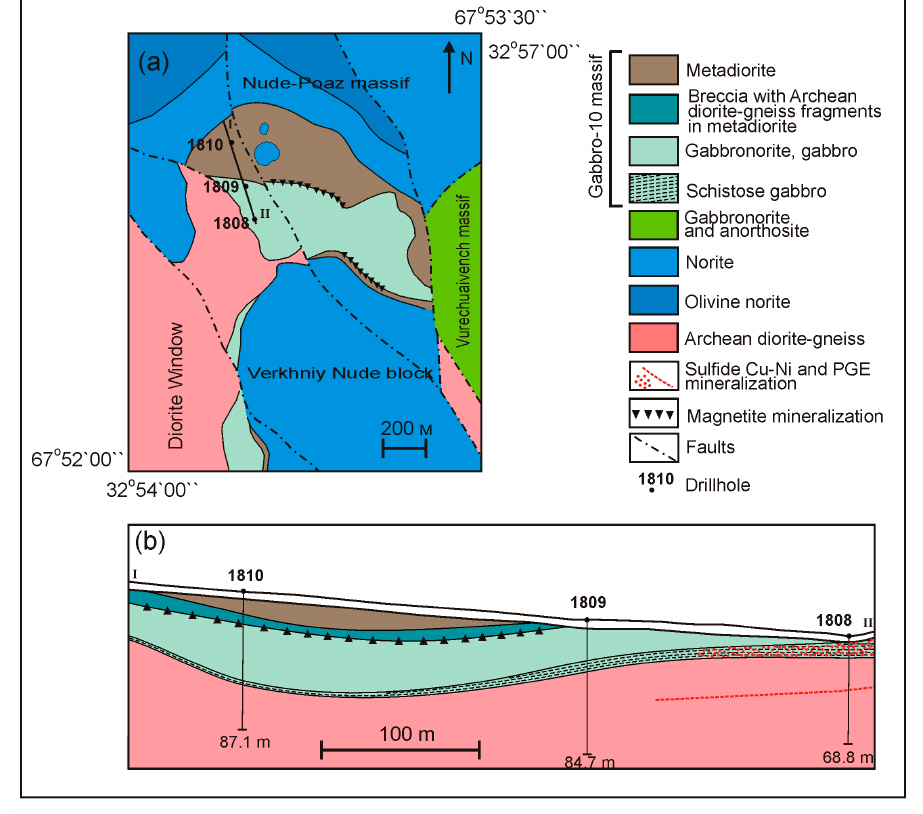
Figure 2. Geological map of the southern part of the Monchepluton ( a ) and the cross section along the well line 1808–1810 ( b ) (modified after [12]).